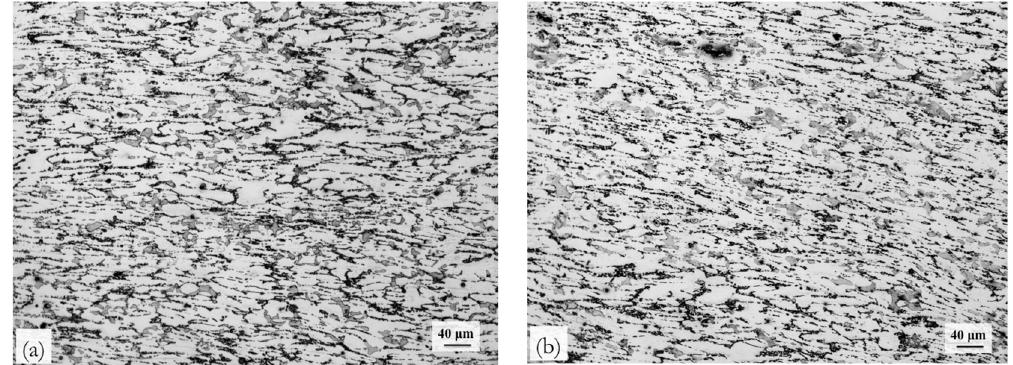
Figure 7. Optical microstructures of the ABaX633 alloy specimens deformed at ( a ) 420 °C/0.0003 s − 1 , and ( b ) 420°C/0.001 s − 1 exhibiting DRX (Domain 1). The compression axis is vertical.